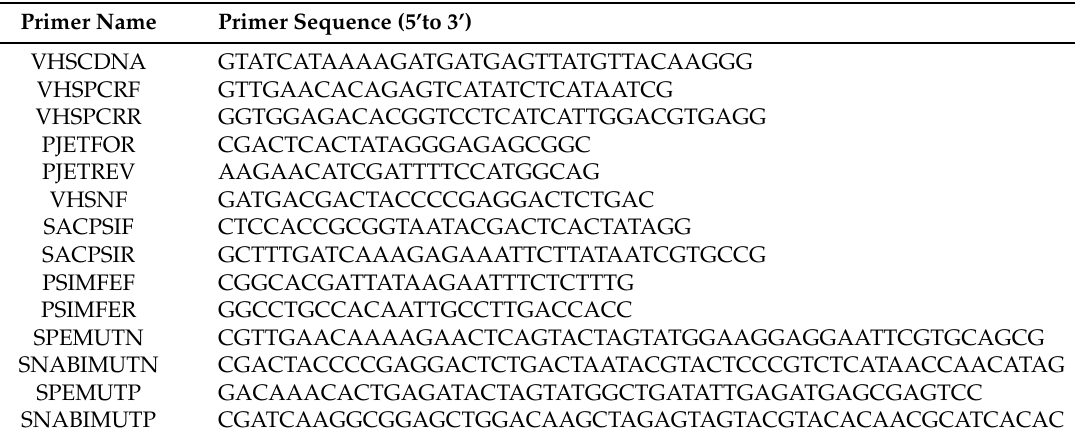
Table 1. Primer sequences used in the